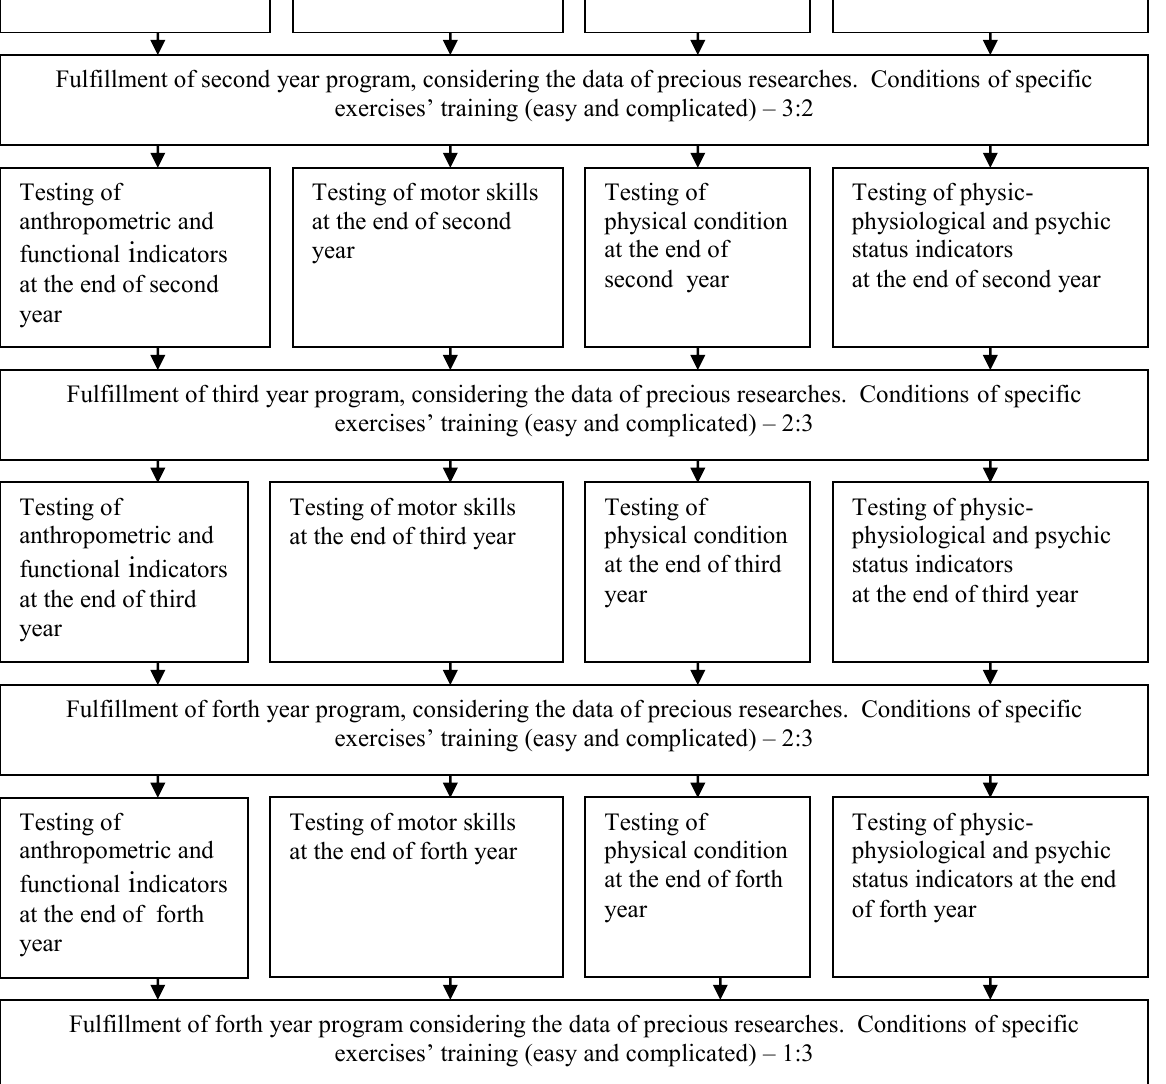
Fig.1. Diagram of application of health related power lifting methodic with students, who have MSA